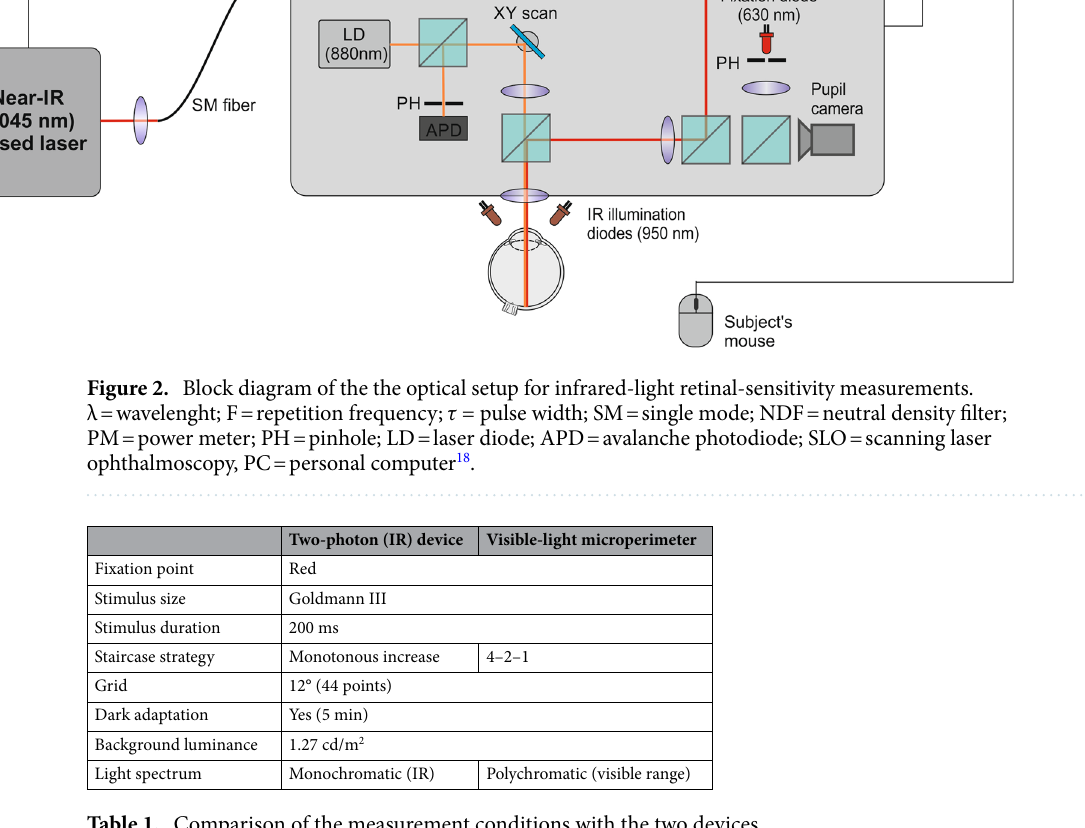
Table 1. Comparison of the measurement conditions with the two